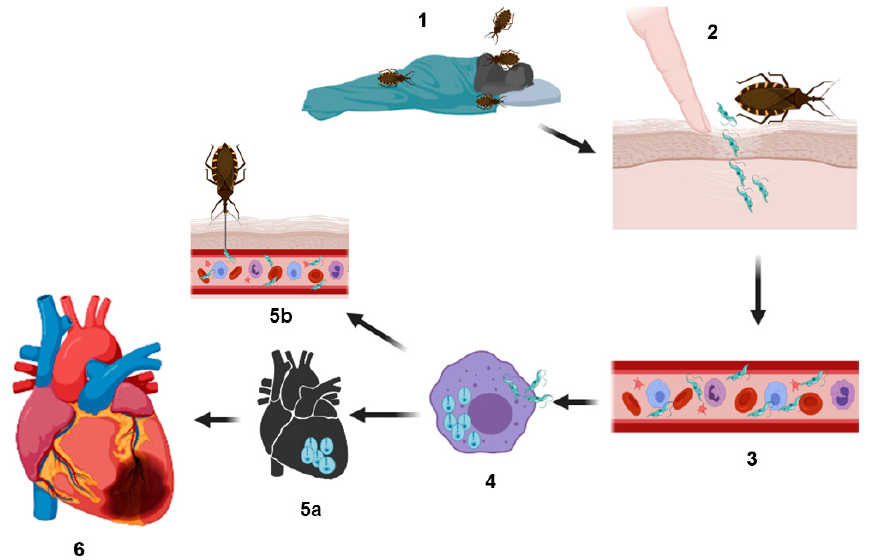
Figure 1. Representation of the biological cycle of Trypanosoma cruzi . Infection is generated when hematophagous bugs reach a mammalian host to feed ( 1 ), infected bug feces (containing the parasite in their form as metacyclic trypomastigotes) are released on the skin (near the bite wound) or in the mucosa of the host. Through micro-wounds caused by scratching excessive or by mucosa route, the parasite reaches the bloodstream ( 2 and 3 ) and invades different types of nucleated cells ( 4 ) (phagocytic and nonphagocytic). The parasitophorous vacuole is formed inside the infected cells to eliminate the parasite; however, T. cruzi trypomastigotes escape this vacuole and differentiate in amastigotes, which are the replicative forms of the parasite in the mammalian host. After several rounds of replication in the cytosol, the amastigotes differentiate into trypomastigotes, and then, the infected cells burst, and the parasites are subsequently released into the bloodstream where they can disseminate to several tissues, mainly the heart, colonizing the cardiac cells and forming the so-called amastigote nests ( 5a ), or they can reinvade the blood cells. Finally, the circulating forms can be taken up by a new triatomine vector during a blood meal, and this vector can infect to another healthy host ( 5b ). In other hand, cardiac affectations can be observed in the acute phase or in the chronic phase; these affectations can be in different degrees of severity ( 6 ) (see text) culminating in a heart attack, which can cause the death of the host.